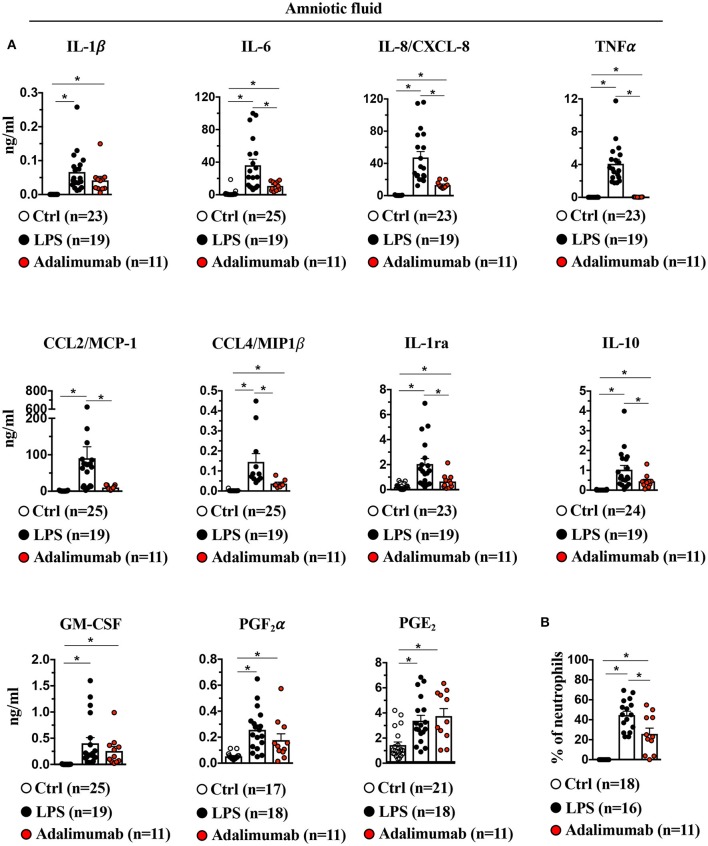
Adalimumab decreased intrauterine inflammation in amniotic fluid. (A) Cytokine and prostaglandins concentrations were measured in amniotic fluid by multiplex ELISA. IL-1β, IL-6, IL-8/CXCL8, TNFα, CCL2/MCP1, CCL4/MIP1β, IL-1ra, IL-10, but not GM-CSF, PGF2α and PGE2 were significantly decreased upon Adalimumab treatment. (B) Adalimumab decreased frequency of neutrophils in amniotic fluid. Data are mean ± SEM, *p < 0.05 vs. controls (Ctrl n = 17–25; LPS n = 16–19; Adalimumab n = 11; Mann–Whitney U-test).